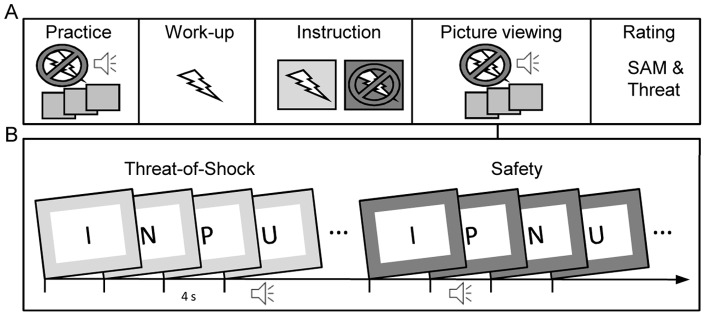
Schematic illustration of the experimental procedure (A) and stimulus presentation (B).Emotional and neutral pictures were randomly presented in a continuous picture stream (each 4 s). Participants were verbally instructed that the colored picture frames (blue or green) indicated either threat-of-shock or safety periods. Abbreviations P, N, U refer to pleasant, neutral, and unpleasant picture contents; I refers to instructions slides announcing “Shock possible” or “No shock” preceding each 72-s period of threat-of-shock or safety.